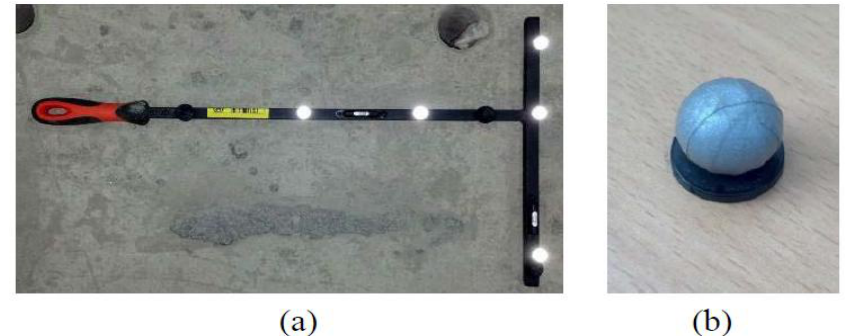
Figure 2. T-shaped wand with five markers. ( a ) Wand; ( b )